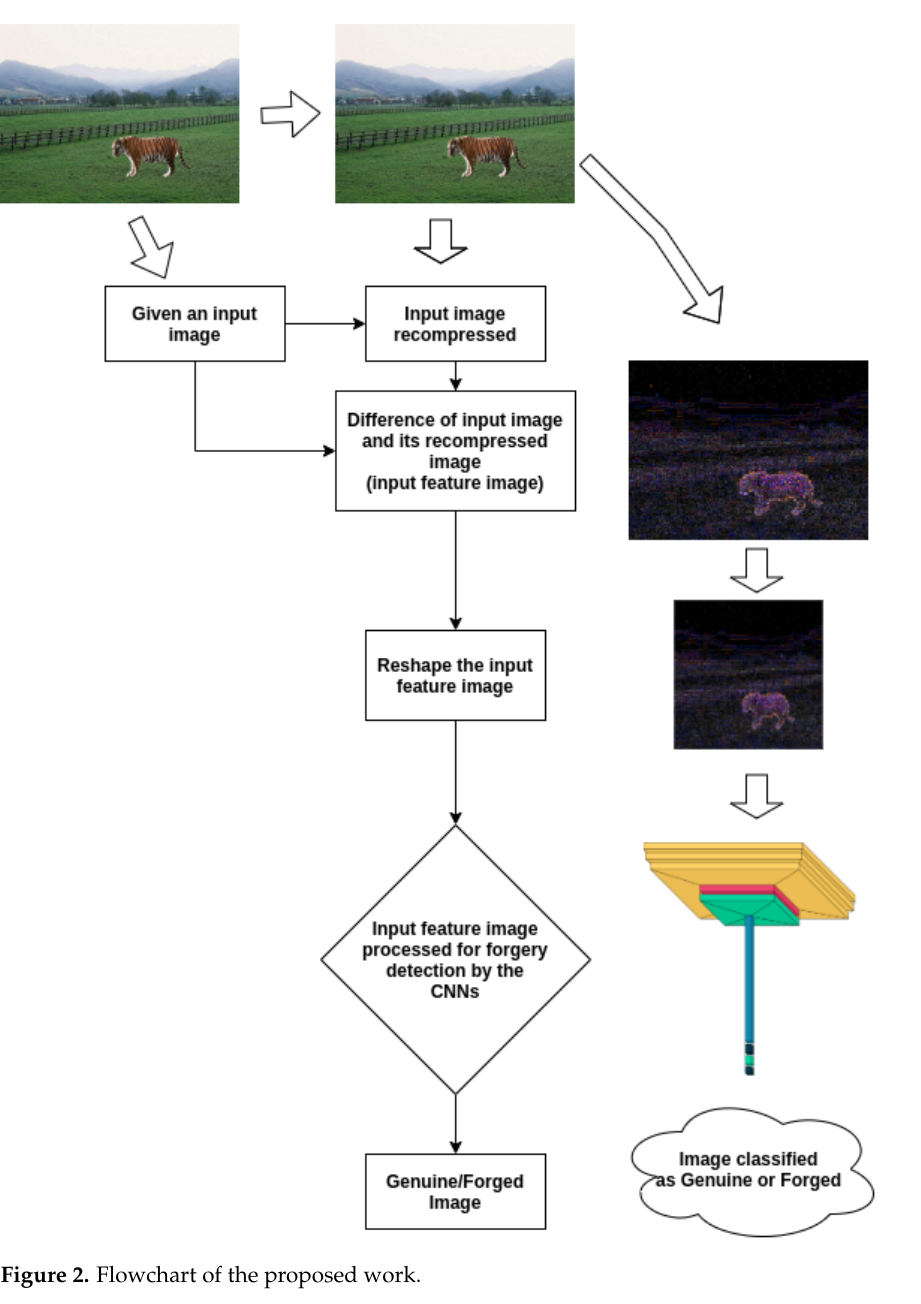
Figure 2. Flowchart of the proposed work.